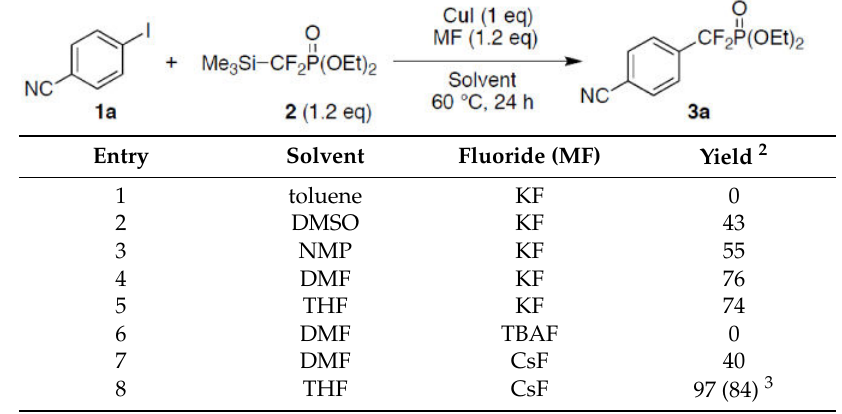
Table 1. CuI-promoted cross-coupling of p -iodobenzonitrile ( 1a ) with [(trimethylsilyl)difluoromethyl] phosphonate ( 2 ): Screening of solvents and fluorides 1